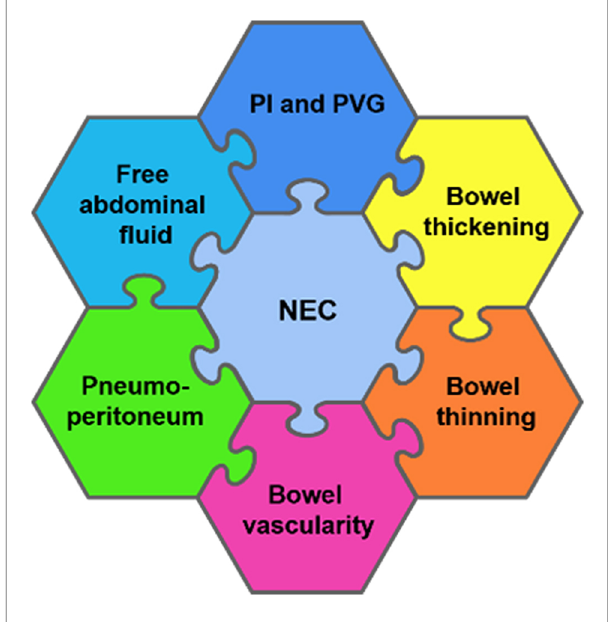
FIGURE 3 A schematic diagram showing a detailed radiological assessment of the neonatal bowel for the diagnosis of necrotizing enterocolitis (NEC). PI, pneumatosis intestinalis and PVG, portal venous